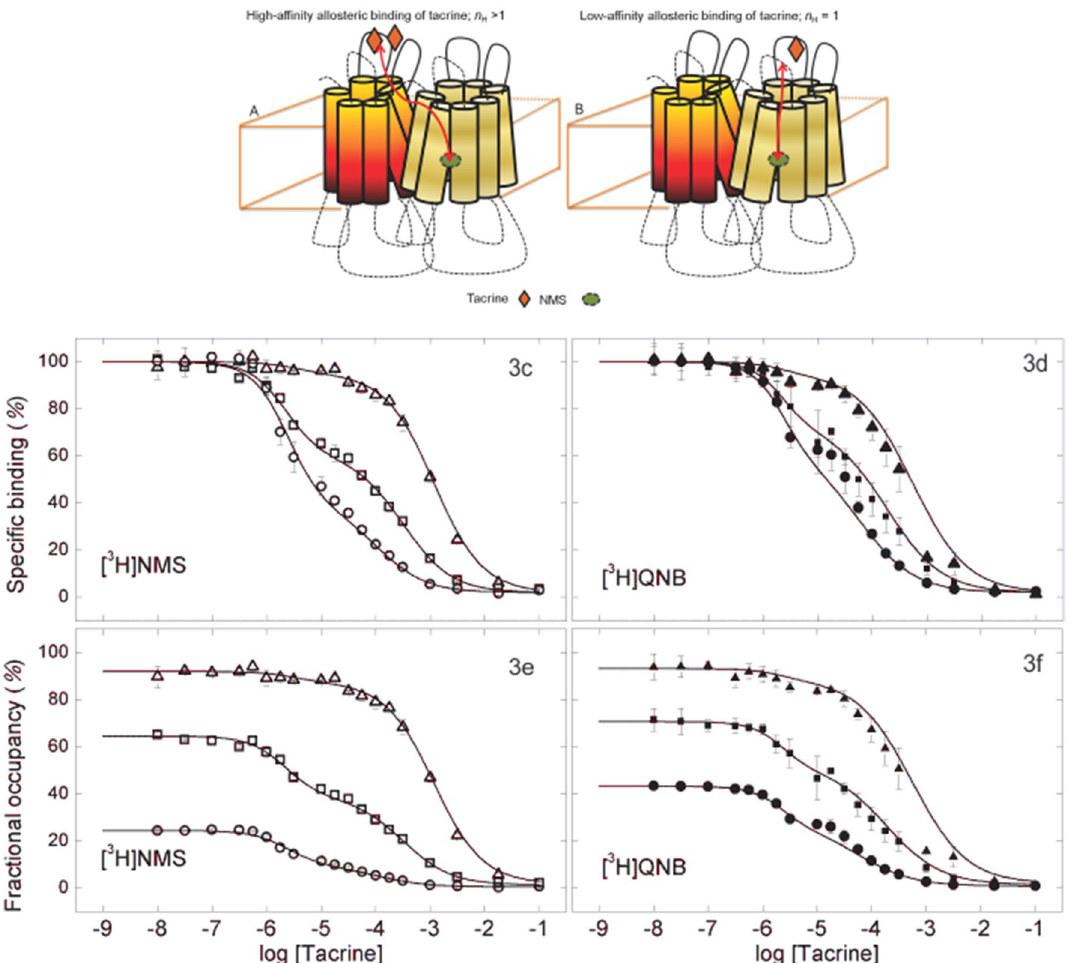
Figure 3. Effect of the concentration of [ 3 H]NMS and [ 3 H]QNB on the binding of tacrine to solubilized M 2 receptor from Sf 9 cells. ( A , B ) A schematic representation of inter- and intra-molecular allosteric modulation within an oligomer, shown here as a dimer, one protomer of which is occupied by NMS. Two equivalents of tacrine bind with high affinity and in a cooperative manner to the protomer with a vacant orthosteric site (left panel). One equivalent of tacrine binds with low affinity to the protomer with NMS at the orthosteric site (right panel). In each case, tacrine acts as a negative allosteric modulator of NMS. Tacrine and either [ 3 H]NMS ( C , E ) or [ 3 H]QNB ( D , F ) were mixed simultaneously with receptor, and the solution was equilibrated for 21 h ([ 3 H] NMS) or 40 h ([ 3 H]QNB) at 30 °C. The concentrations of each radioligand and the corresponding levels of occupancy in the absence of tacrine were as follows: for [ 3 H]NMS, 3.16 nM and 24.4% (open circle), 17.8 nM and 64.5% (open square), 112 nM and 92% (open triangle); for [ 3 H]QNB, 1.01 nM and 57.4% (filled circle), 1.79 nM and 70.6% (filled square), 10 nM and 93% (filled triangle). Three experiments were performed at each concentration. The data represented in the figure plus similar data acquired at three additional concentrations of [ 3 H]NMS or [ 3 H]QNB were analyzed simultaneously in terms of Eq. (3) ( n = 2). The fitted curves are depicted by the lines in the figure, and the parametric values are listed in Table